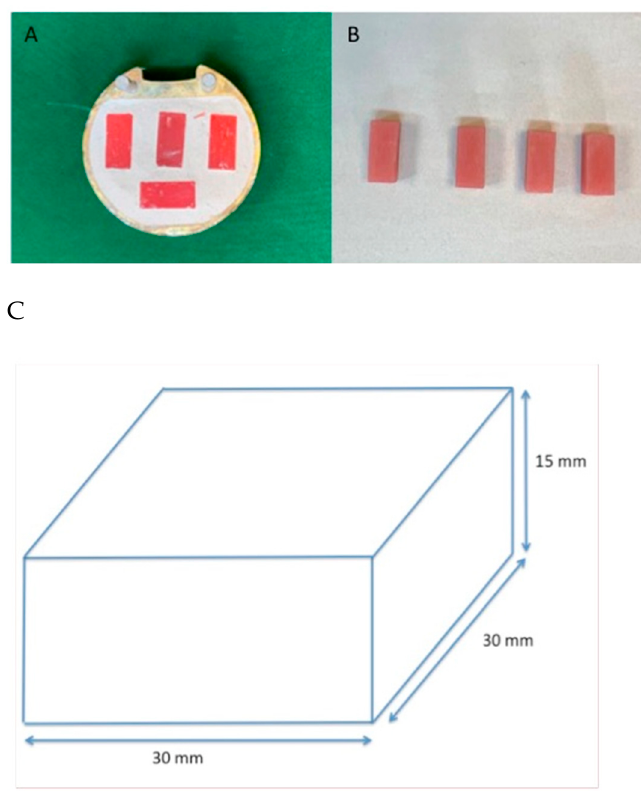
Figure 1. PMMA sample fabrication. ( A ) PMMA packing in plaster molds and ( B ) Finished PMMA samples. ( C ) Dimensions of each PMMA sample.